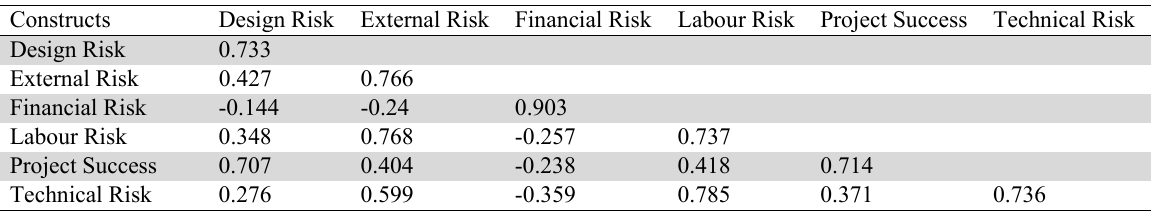
Fornell-Larcker criterion Constructs